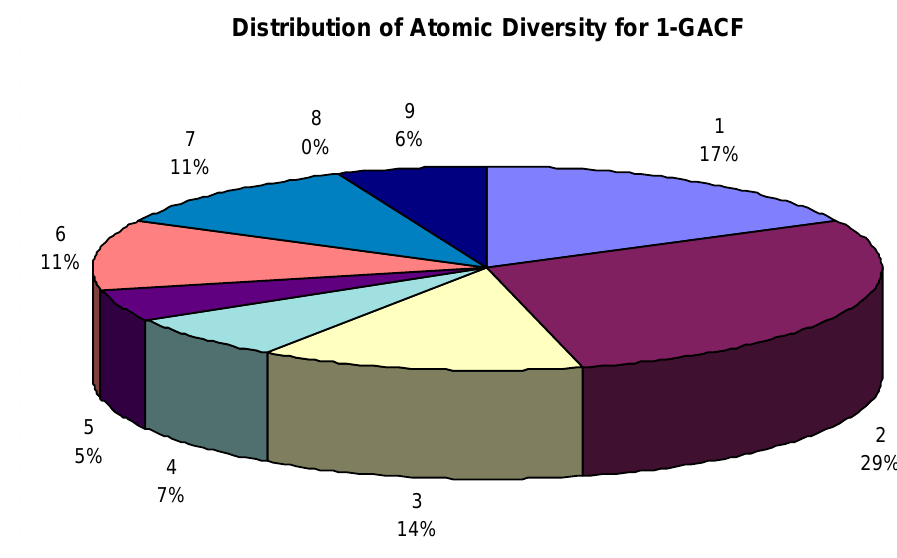
Figure 9. The GACF class distribution. The number over the percentage figure is the code of a GACF class (refer to Table 1.). The largest portion of this knowledge body is regarding fused non-aromatic carbon atom chemical shifts. 0% actually means <1% (due to the poor resolution of the graphic display).